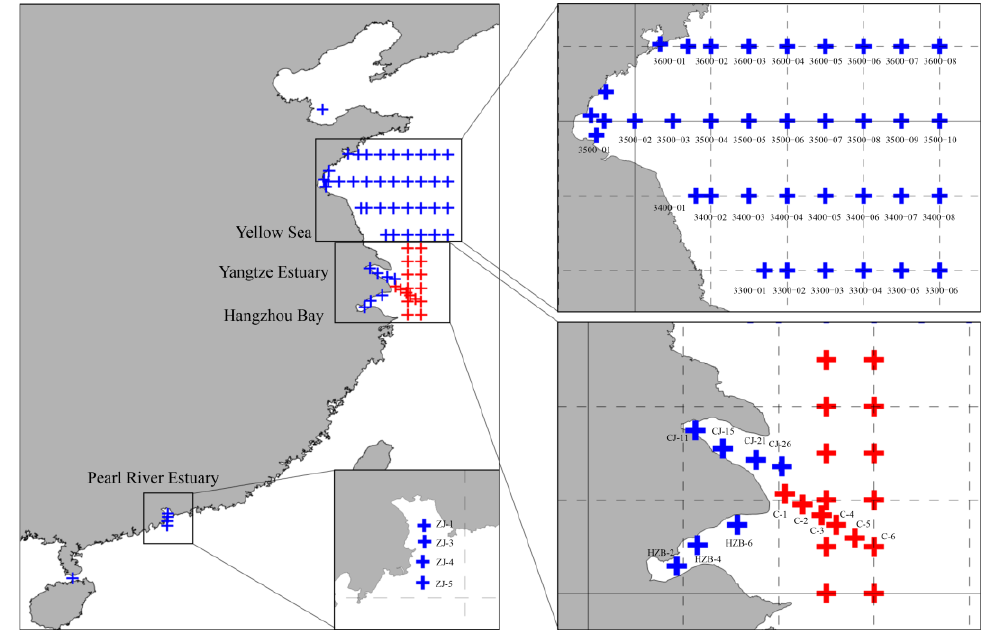
Figure 1. Schematic diagram of sampling area (Samples collected in 2018 are represented by a blue sign, while those collected in 2019 are represented by a red one).